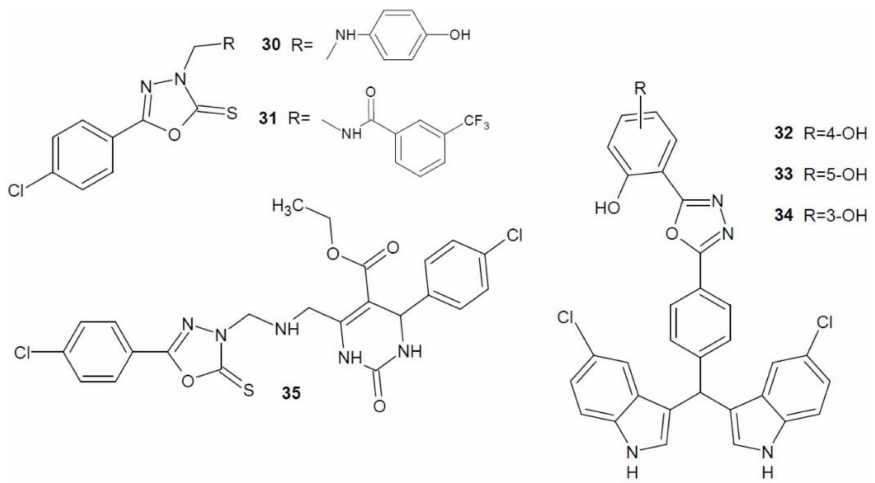
Figure 13. 1,3,4-Oxadiazole derivatives with activity of thymidine phosphorylase inhibitors (part 2).